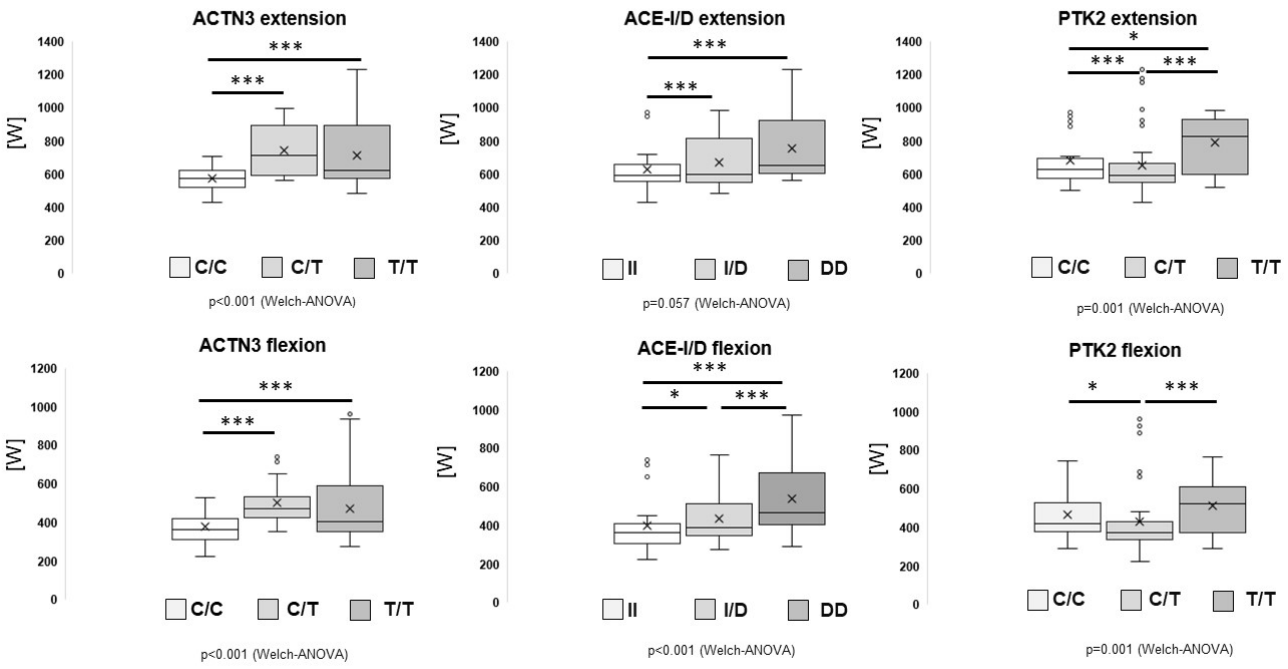
Figure 3. Main genotype associations with strength. Box-whisker plots for peak power during isokinetic single contractions at 360 ◦ sec − 1 in extension and flexion for the studied genotypes for the ACTN3 (rs1815739), ACE-I/D (rs1799752) and PTK2 (rs7843014) gene polymorphisms. Repeated measures ANOVA with post hoc test of least significant difference. The corresponding p-values for the Welch type ANOVA are indicated below each panel. * and *** indicate, p ≤ 0.05 and 0.001, respectively, for the indicated comparisons.